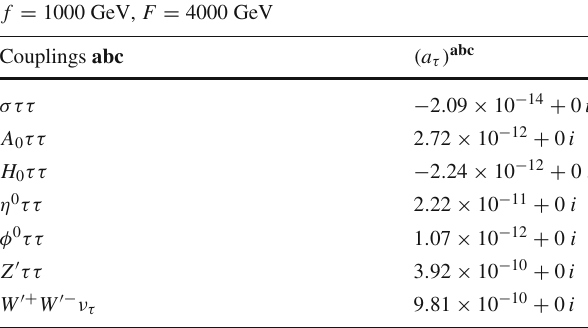
Table 4 The magnitude of the partial contributions to a τ of the BLHM. The data are obtained by fixing the f and F scales, f = 1000 GeV and F = 4000 GeV. The values provided in Table 3 are used for the rest of the model parameters. abc denotes the different particles running in the loop of the vertex γτ + τ − f = 1000 GeV, F = 4000 GeV Couplings abc